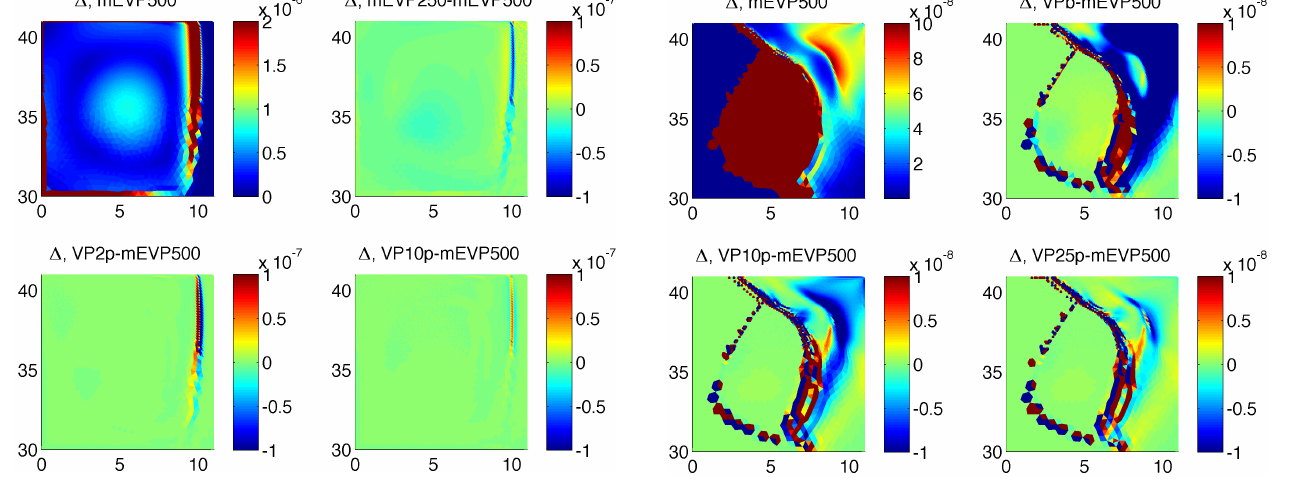
Figure 3. Same as in Fig. 2 but for the “divergence” (cid:49) (s − 1 ) after 1 month of simulations. Additional Picard iterations in the PV method lead to very good agreement between mEVP and VP solutions.